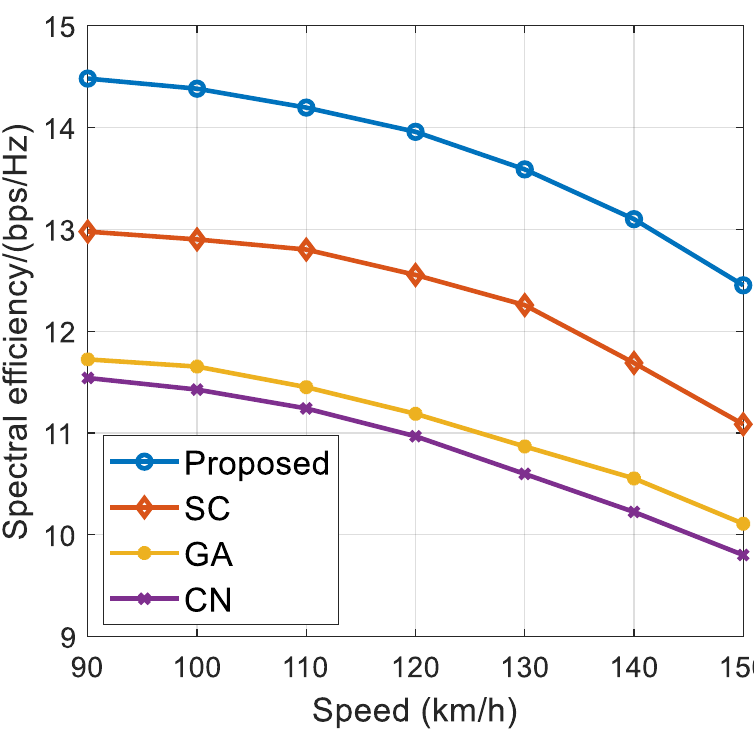
Figure 7. The influence of different vehicle speeds on spectrum efficiency.